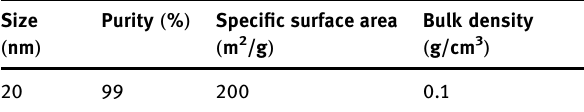
Table 5: Properties of NS sol –